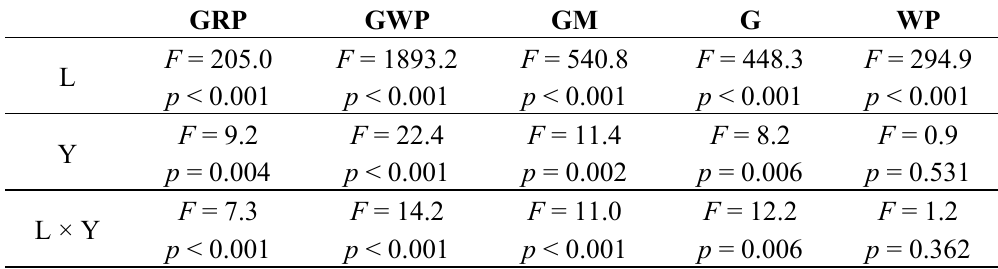
Table 4. Two-way repeated measures ANOVA results for soil layer (L) and year (Y), on total soil C (t·ha − 1 ). Each planting treatment was analyzed separately. Degrees of freedom for main effects and their interactions were F 4,40 , and F 16,40 , respectively.